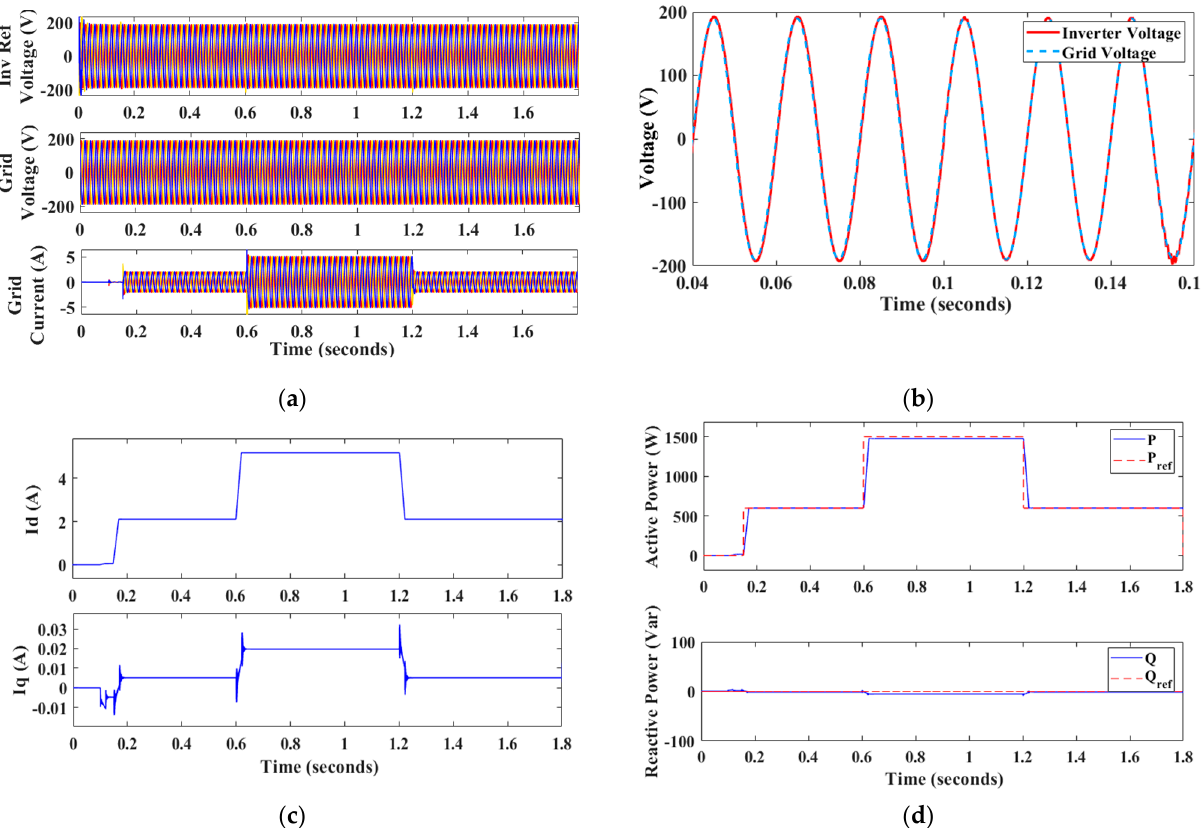
Figure 9. ( a ) Three phase inverter reference voltage, grid voltage and grid current; ( b ) inverter reference voltage and grid voltage of phase-A, ( c ) I d and I q of inverter output current; ( d ) active and reactive power flow to the grid.